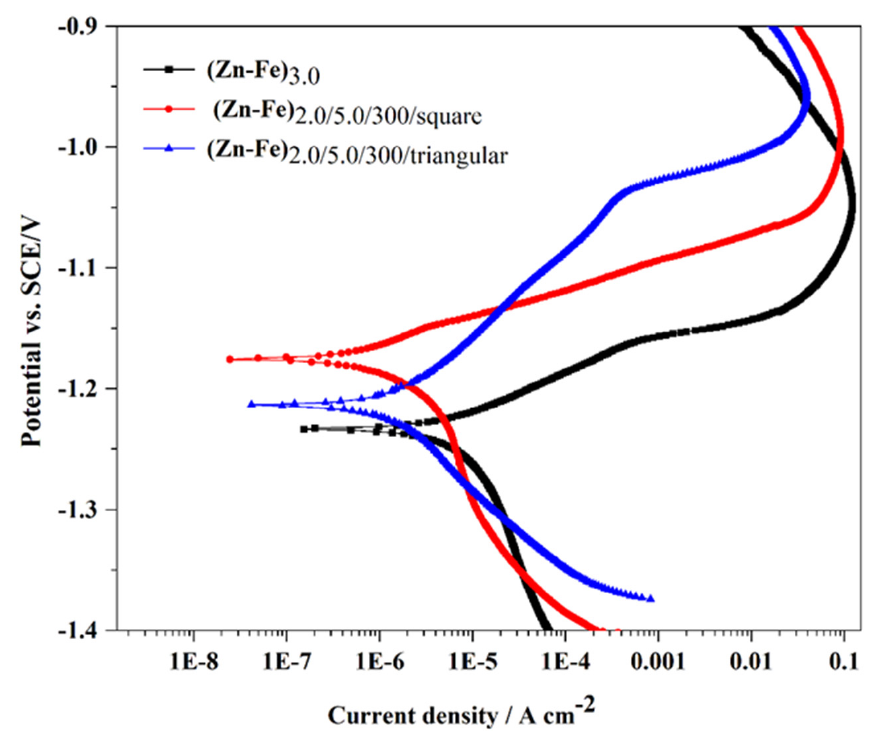
Figure 3. Potentiodynamic polarization curves of SL and ML alloy